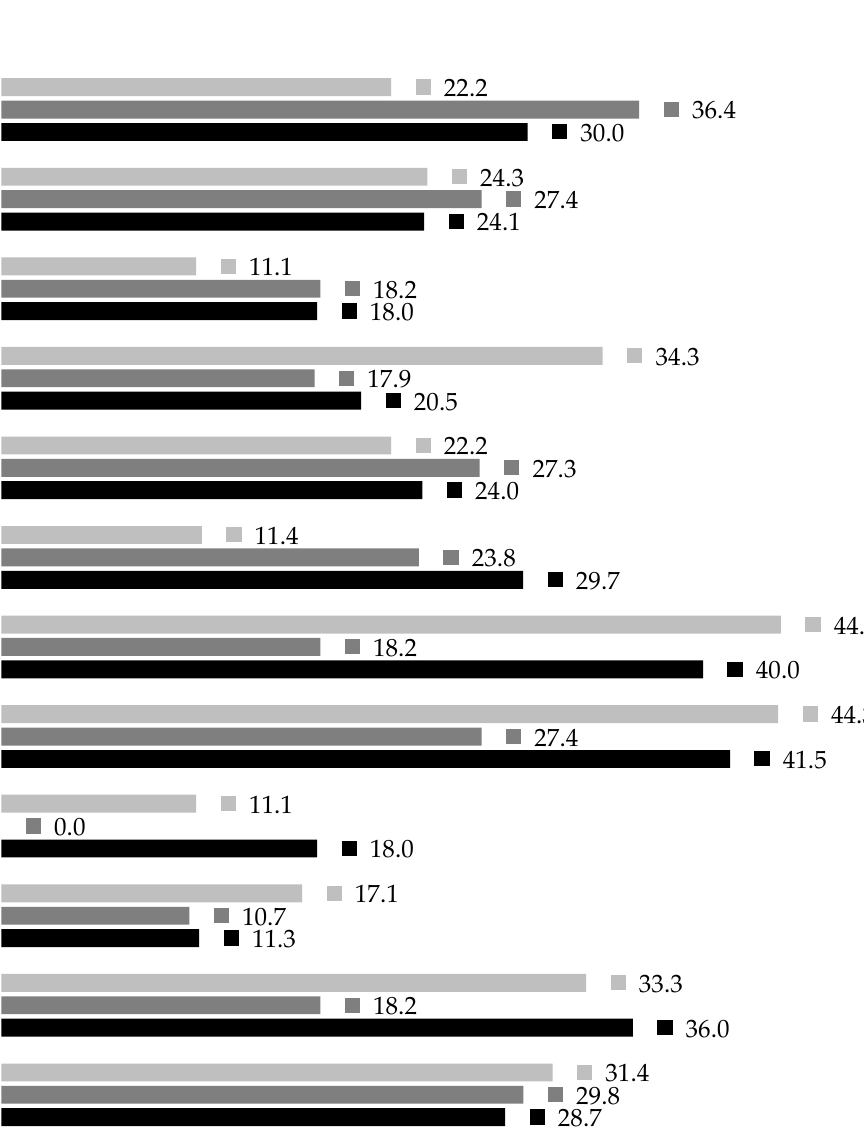
Table 3. Variables of influence on EBITDA in the IBEX 35 companies.